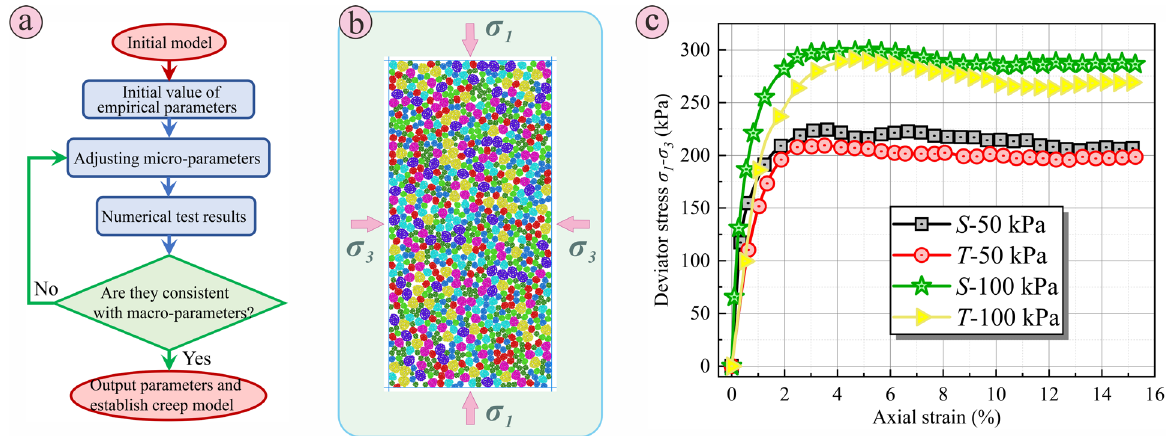
Figure 8. Calibration process of the parameters: ( a ) Flow chart of parameters calibration; ( b ) Biaxial test; ( c ) Comparison of experimental and numerical results, S and T denote the results of numerical simulation and test respectively. Table 2. Parameters used in the DEM simulations.